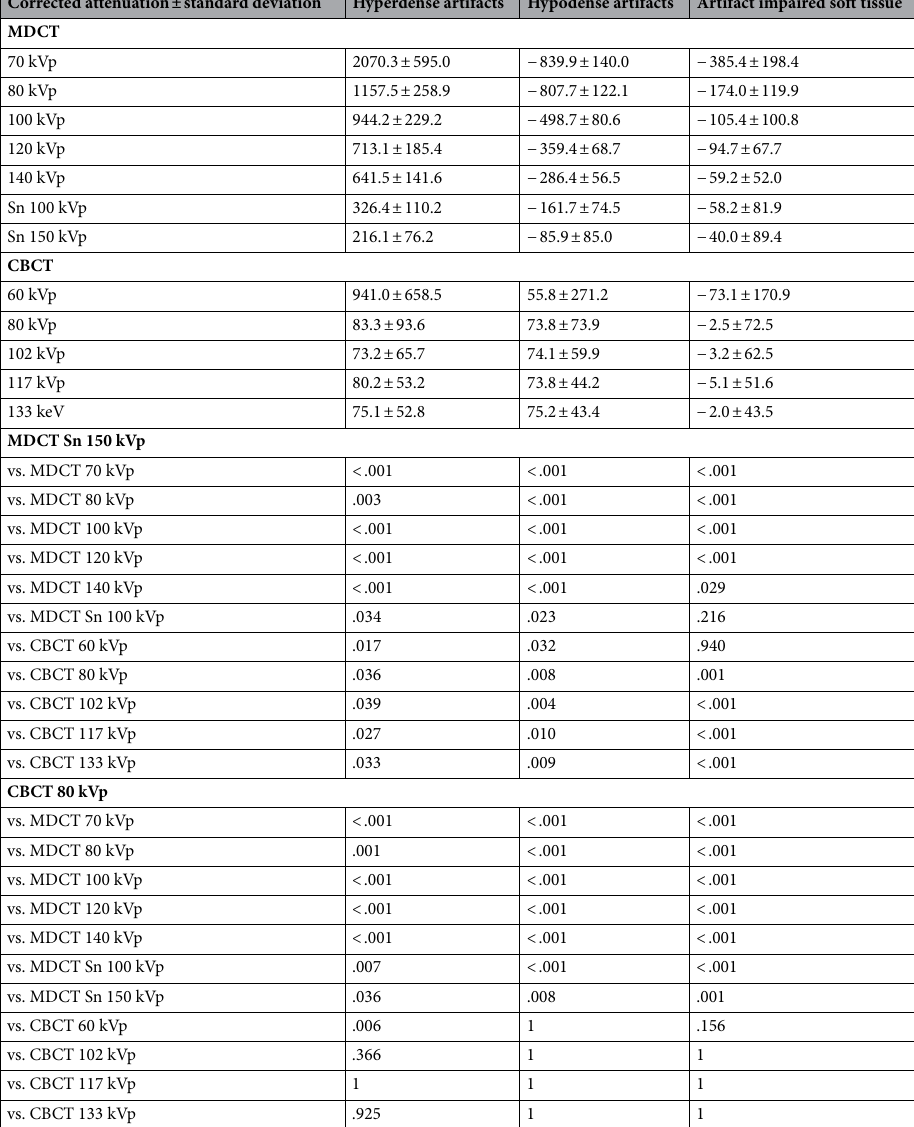
Table 2. Semiquantitative assessment of artifact reduction. CBCT, cone-beam computed tomography; kVp, kilovoltage peak; MDCT, multidetector computed tomography; Sn, 0.4 mm tin